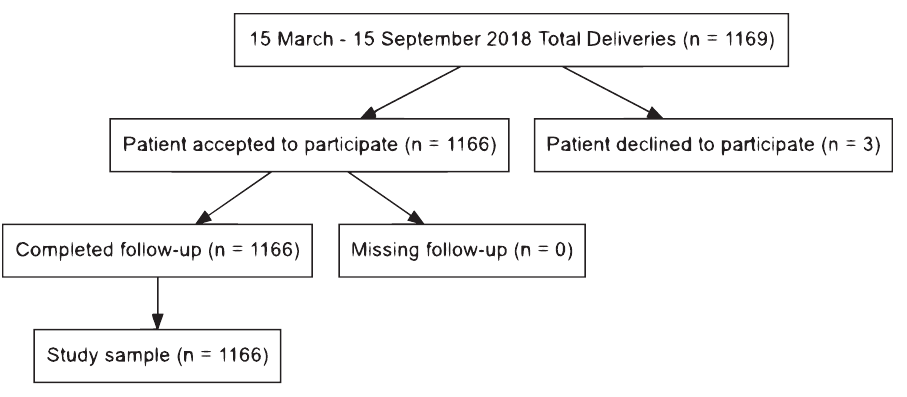
Fig 1. Patients flowchart according to the STROBE